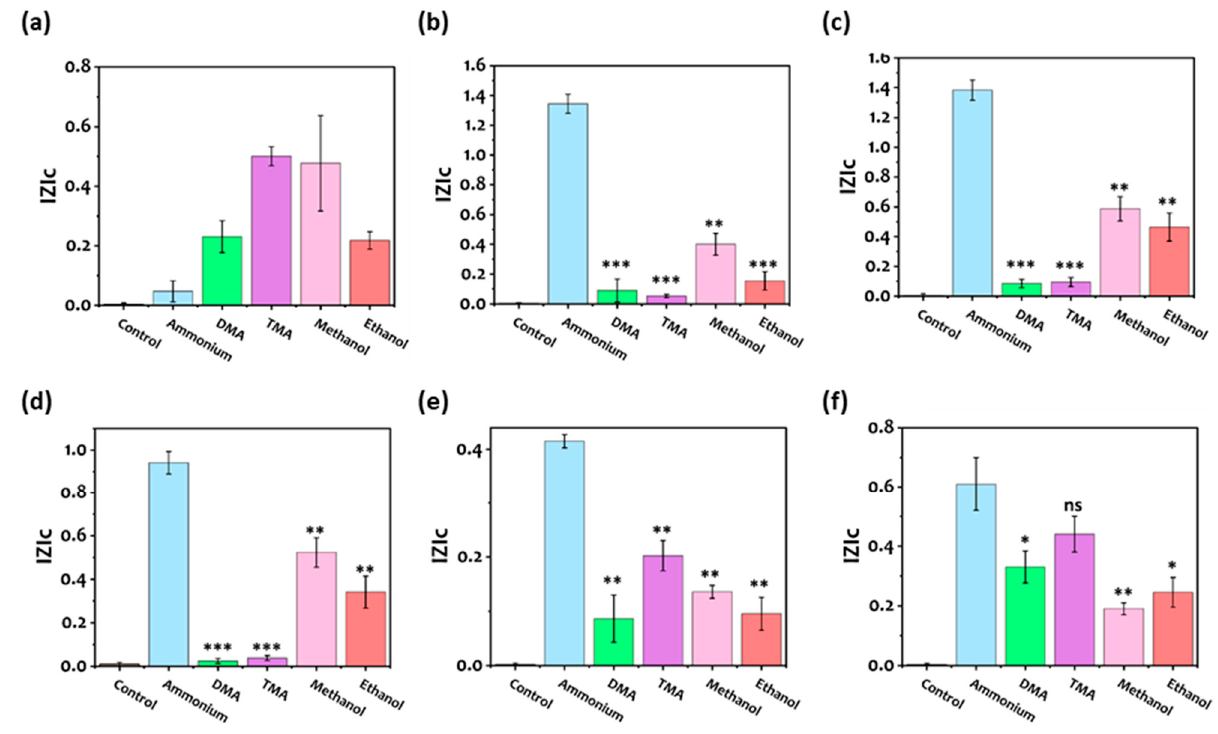
Figure 6. ( a – f ) Selectivity test for the detection of ammonium. ( a ) Control aptamer, ( b ) aptamer 1, ( c ) aptamer 2, ( d ) aptamer 3, ( e ) aptamer 4, and ( f ) aptamer 5. The concentrations of ammonium and non-target chemicals were 100 µM. Data are expressed as means ± SE; Statistical significance was assessed with a two-way ANOVA with Dunnett’s multiple comparison test for ammonium and other analytes, * p ≤ 0.5, ** p ≤ 0.05, *** p ≤ 0.0001, ns—not significant.